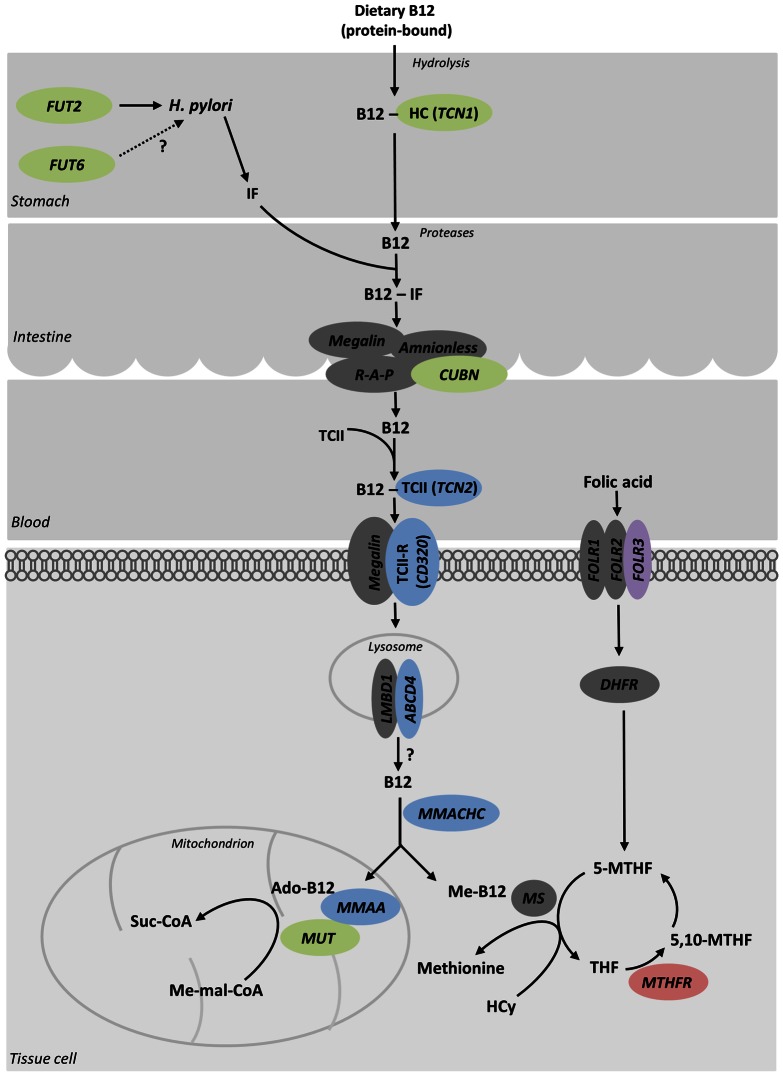
Genes that associate with serum B12 and folate levels are in pathways affecting their metabolism.Genes previously identified to harbor variants regulating serum levels of B12 are shown in green. In blue are novel genes identified in the present study. In red, genes containing variants previously suggested to associate with serum folate and in purple are novel genes for serum folate. B12: vitamin B12; HC: Heptocorrin (TCN1); IF: Intrinsic factor; R-A-P: Receptor-Associated-Protein; CUBN: cubilin (intrinsic factor-cobalamin receptor); TCII: Transcobalamin II (TCN2); TCII-R: Transcobalamin II receptor (CD320); MMACHC: methylmalonic aciduria (cobalamin deficiency) cblC type, with homocystinuria; MMAA: methylmalonic aciduria (cobalamin deficiency) cblA type; ABDC4: ATP-binding cassette, sub-family D (ALD), member 4; LMBD1: LMBR1 domain containing 1; FOLR1–3: folate receptors 1–3; Ado-B12: Adenosyl-cobalamin; Me-B12: Methyl-cobalamin; Me-mal-CoA: Methyl-malonyl-CoenzymeA; Suc-CoA: Succinyl-CoenzymeA; MUT: methylmalonyl-CoA mutase; H. pylori: Helicobacter pylori; DHFR: Dihydrofolate reductase; MS: methionin synthase; THF: Tetrahydrofolate; 5,10-MTHF: 5,10-Methyl-tetrahydrofolate; Hcy: Homocysteine MTHFR: 5-methyl-tetrahydrafolate reductase.